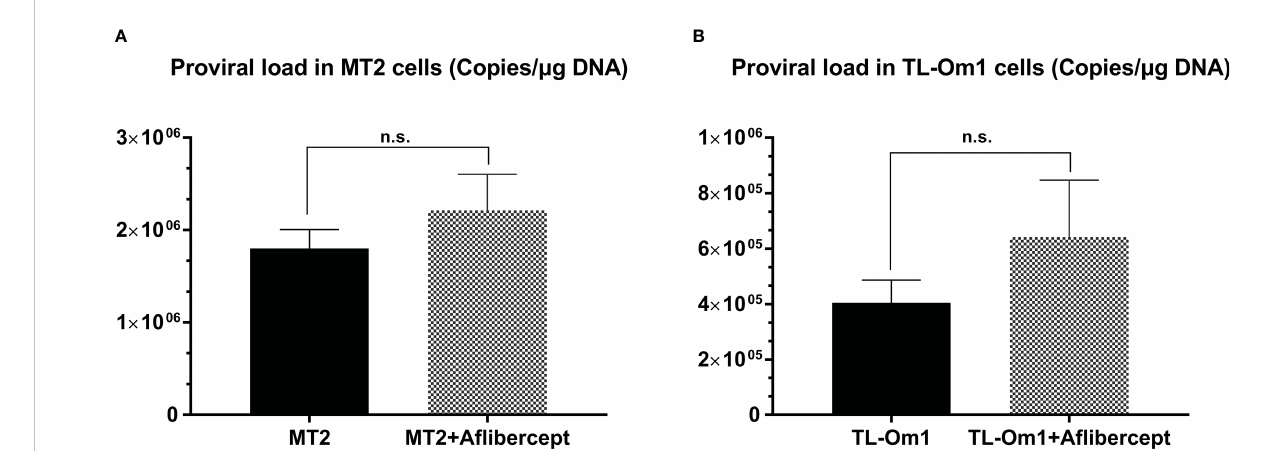
FIGURE 5 Proviral load (PVL) in MT2 cells (A) or TL-Om1 cells (B) treated with/without 0.5 mg/mL a fl ibercept for 48 (h) The number of each type of cells was 5 × 10 5 . A fl ibercept had no effect on the PVL of either cell type. Data are taken from three independent biological experiments and presented as the mean ± SEM (n.s., not signi fi